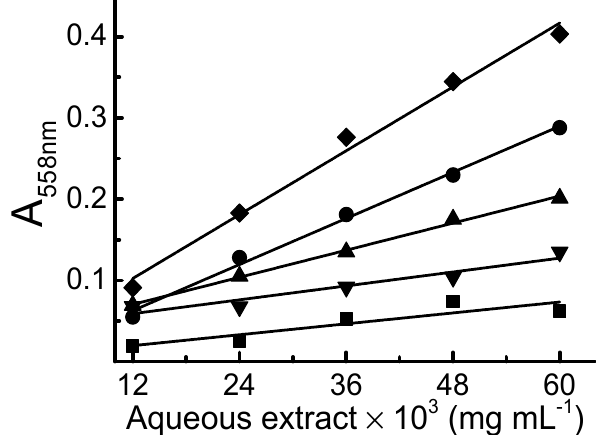
Figure 3. Addition of five aliquots of plant extracts in a solution containing 5.0 × 10 − 4 M Cu(II) + 1.5 × 10 − 3 M BCA + 0.8 M ammonium acetate. ■ = Geissospermum leave (Vell.) Miers; ▼ = Annona muricata L.; ▲ = Bauhinia splendens Kunth; ● = Carapa guianensis Aubl. And ♦ = Salacia impressifolia (Miers) A. C. Sm. A 558nm values taken using freshly prepared Cu(BCA) 23 − complex as reference solution.